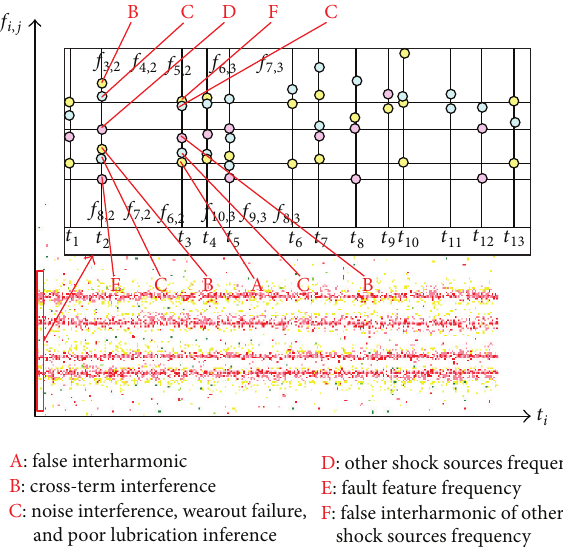
Figure 8: Schematic diagram of amplitude relevancy